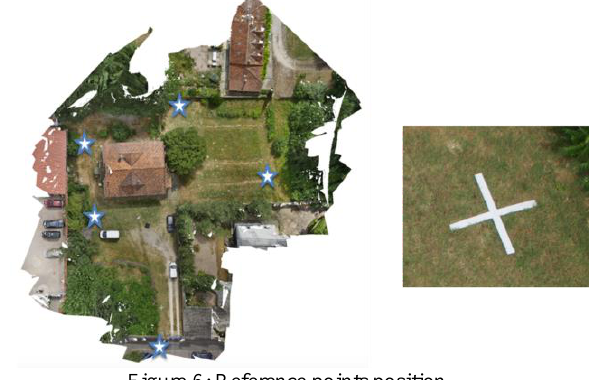
Table 2: Error for the reference points